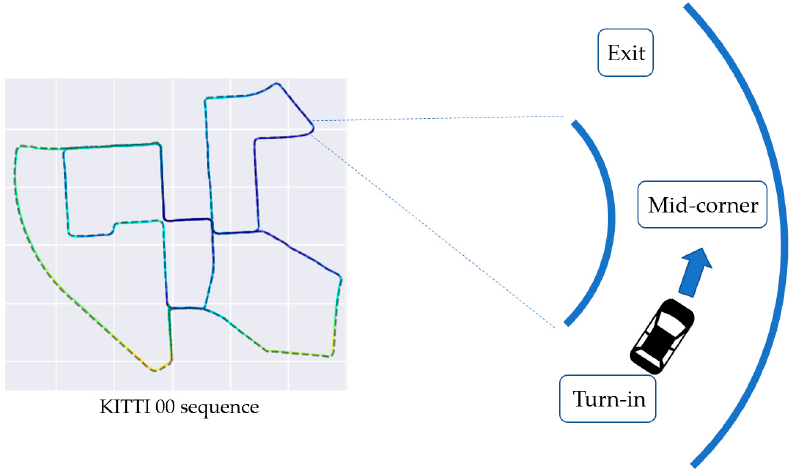
Figure 5. Turn-in, mid-corner, and exit involved with a cornering section [38].